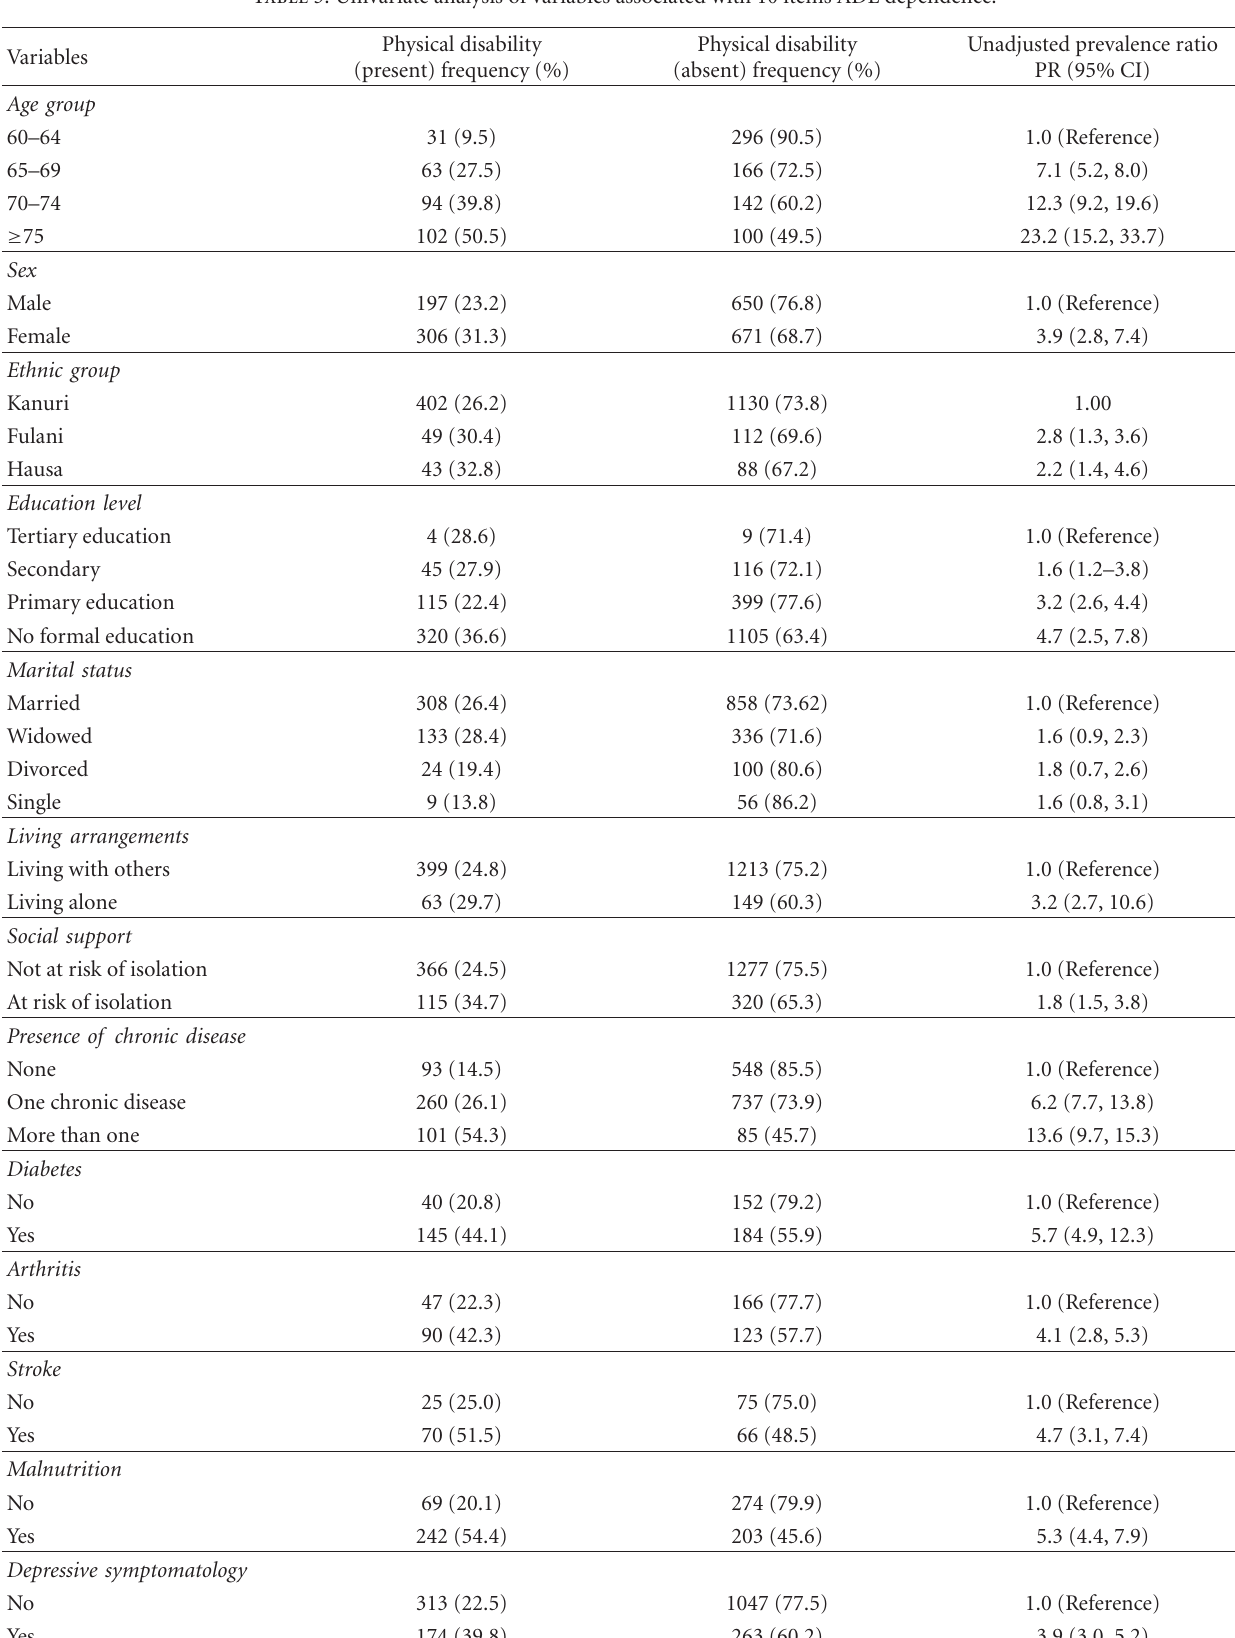
Table 3: Univariate analysis of variables associated with 10 items ADL